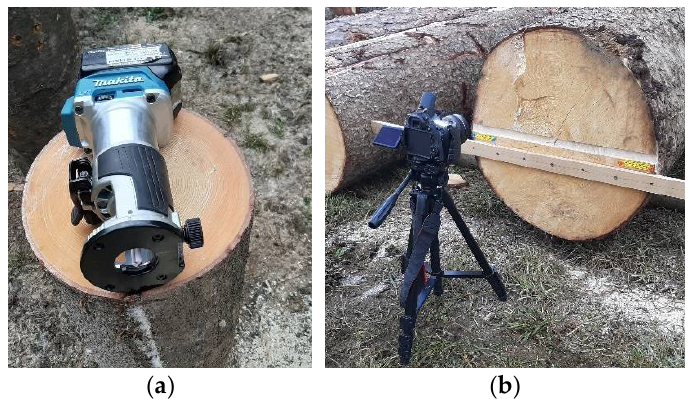
Figure 4. The principle of creating a groove in the cross-section of the log ( a ) and the image acquisition ( b ).